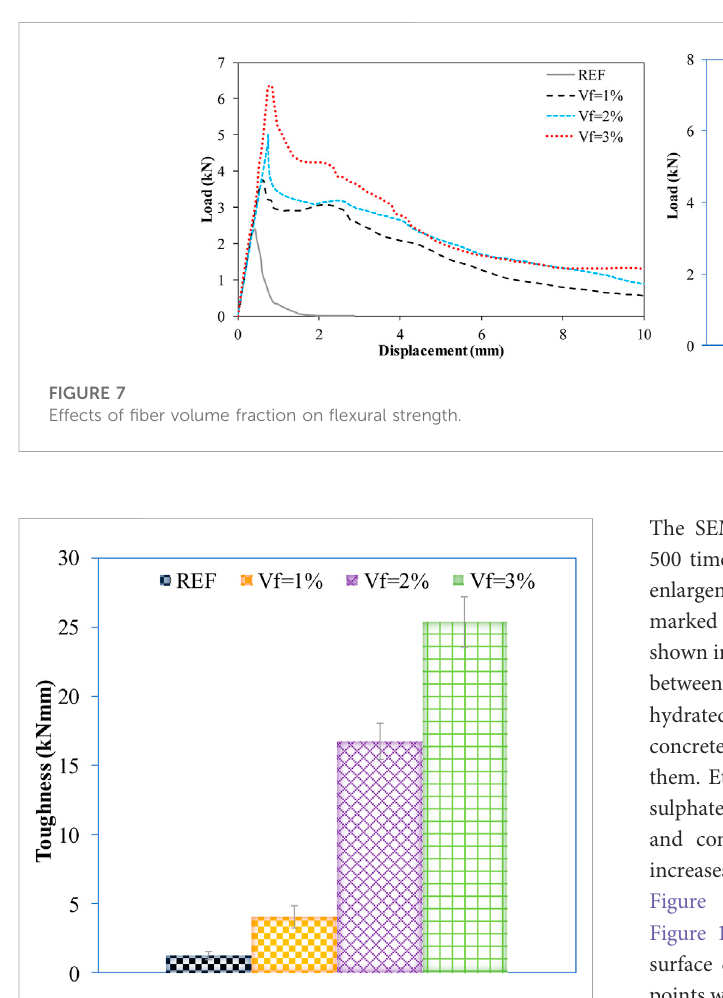
FIGURE 8 Effects of fi ber volume fraction on